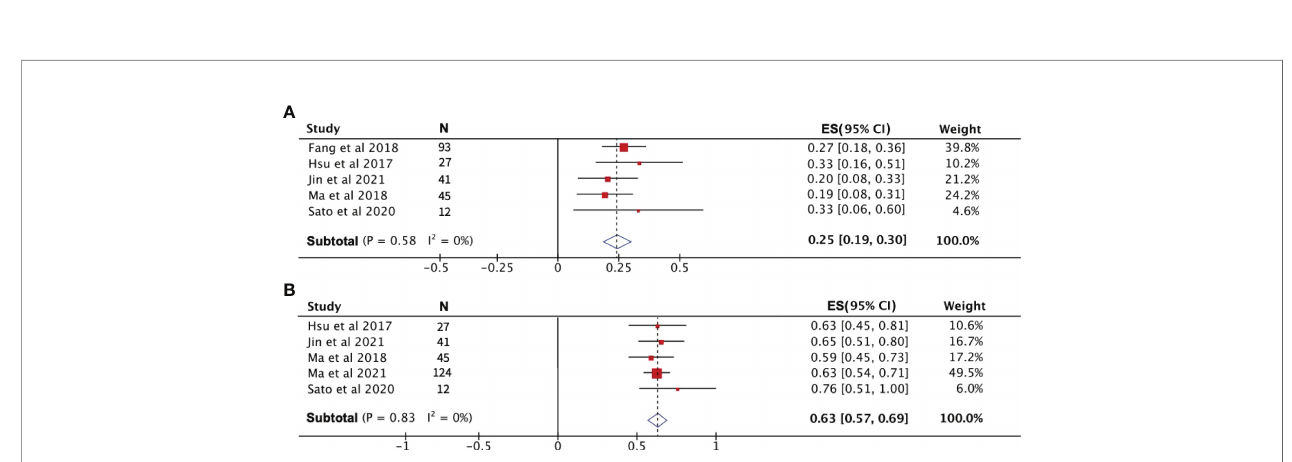
FIGURE 4 | The 1-year progression-free survival rate (A) and overall survival rate (B) of patients receiving PD-1